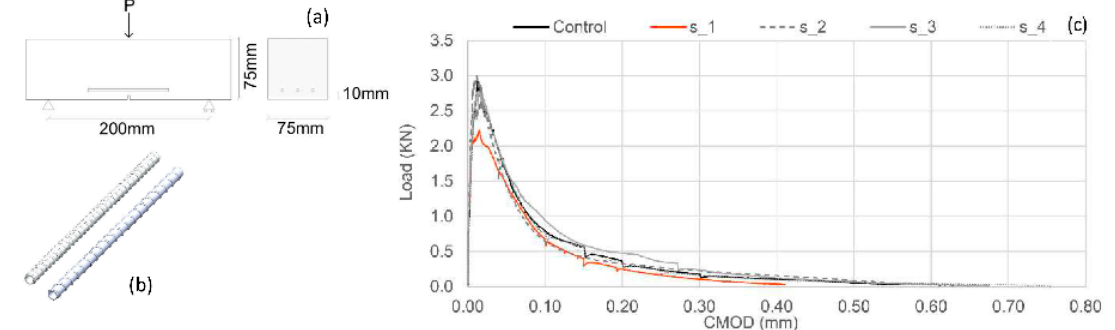
Figure A3. ( a ) Three-point bend test setup on samples containing 3 tubes. ( b ) Examples of tubes with